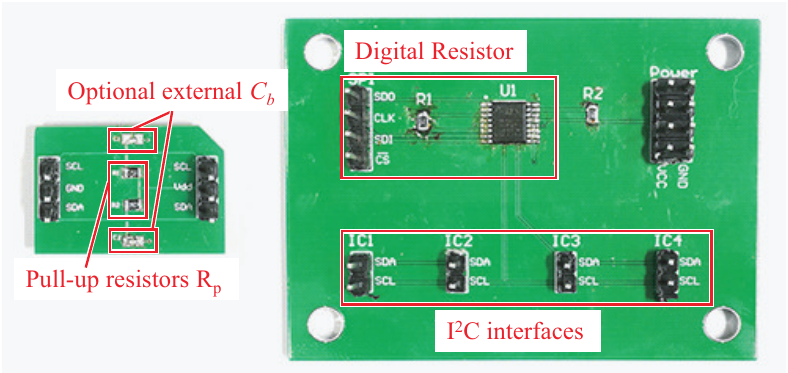
Figure 10. Experiment platforms. The left is a mini-test board, while the right is a multi-chips test